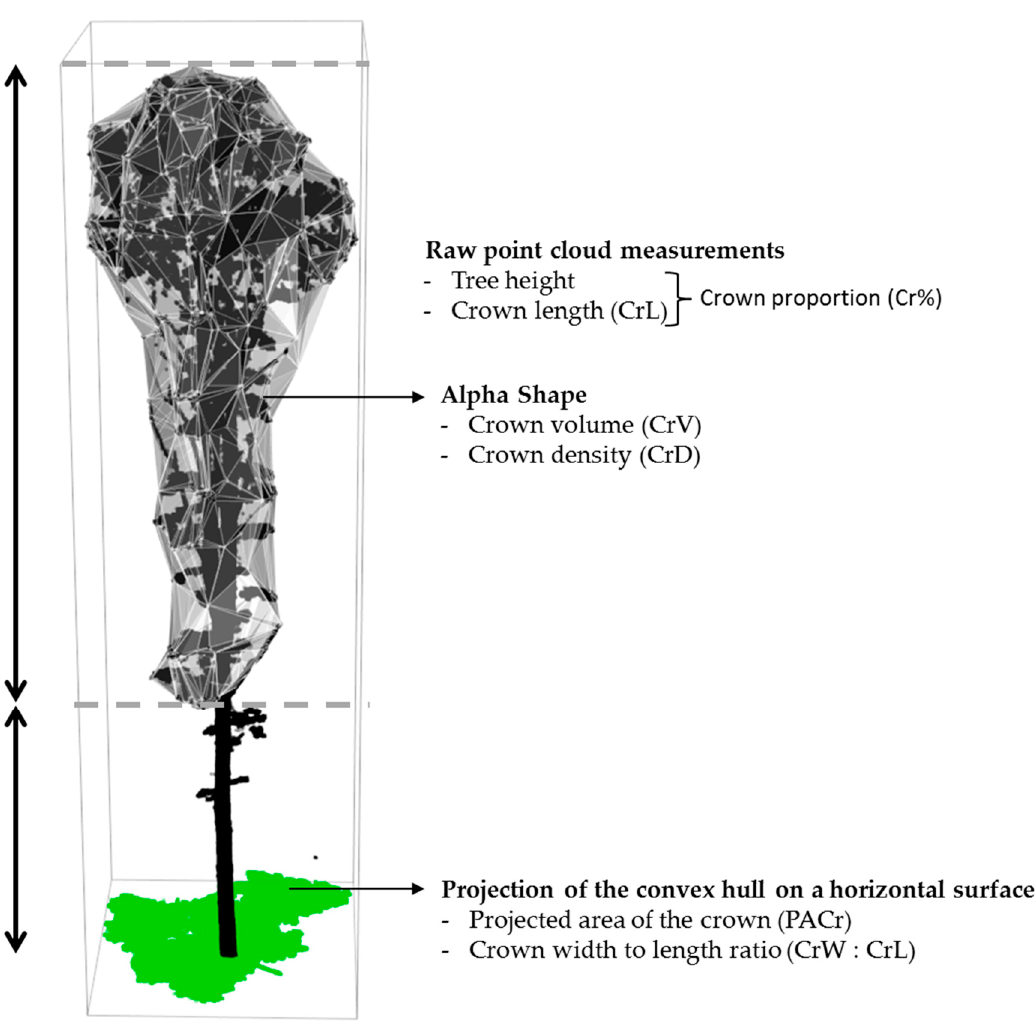
Figure 3. Illustration of the six crown metrics quantified on a mature sugar maple 3D point cloud.